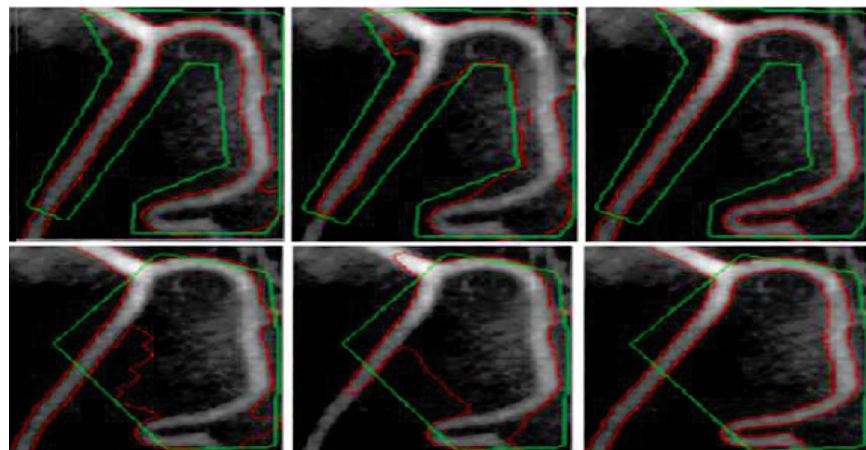
FIG. 4. SEGMENTATION EFFICIENCY OF THREE METHODS AGAINST TWO DIFFERENT INITIALIZATIONS ON SYNTHETIC VASCULAR IMAGE (LEFT) LOCALIZATION METHOD (MIDDLE) YIN’S METHOD (RIGHT) PROPOSED METHOD, GREEN IS INITIALIZATION AND RED IS FINAL SEGMENTATION